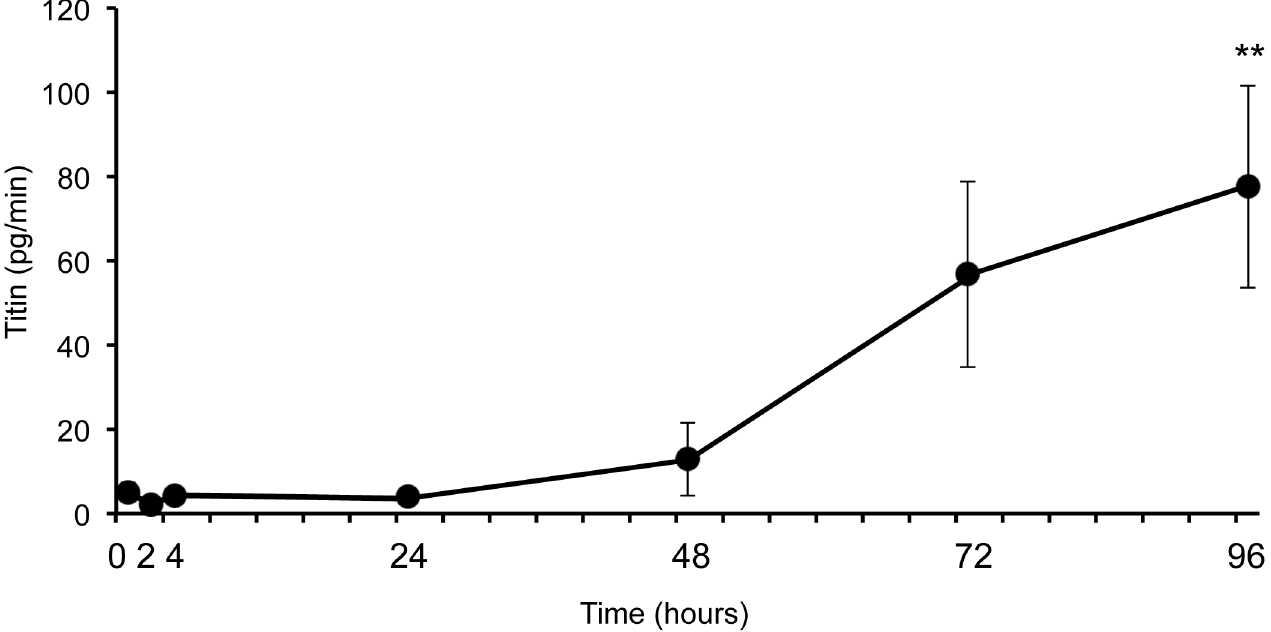
Fig 5. Rate of urinary titin fragment excretion after eccentric exercise. The urinary titin fragment excretion rate was calculatedas the concentration × gross amount of urine per minute. The urinary titin fragment excretionrate increasedsignificantly 96 h after exercise. Values are expressedas means ± SE (n = 9). ** p < 0.01 vs Pre.